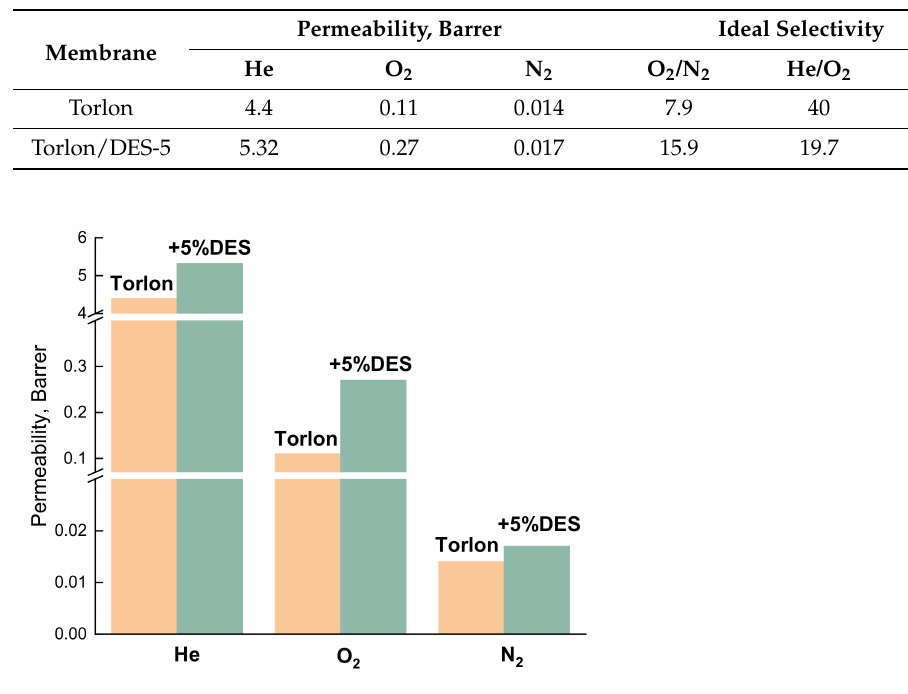
Table 3. Gas transport properties of membranes at 30 ◦ C.